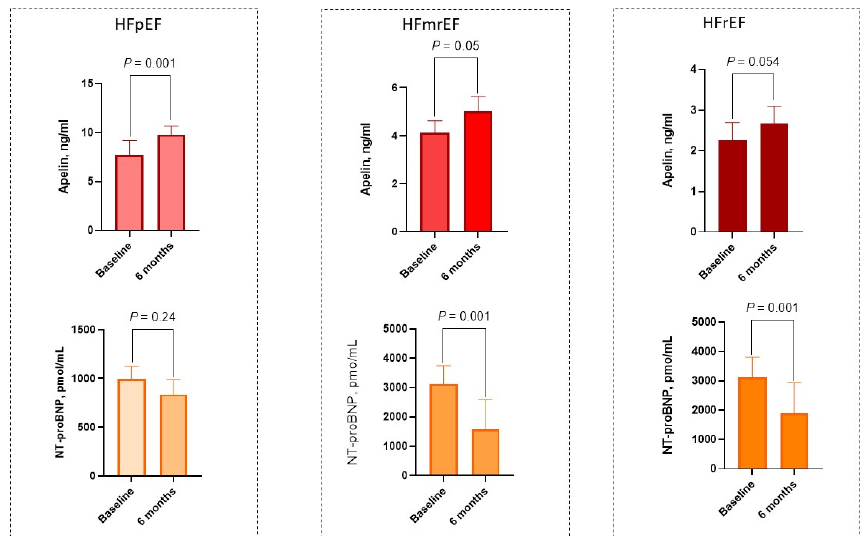
Figure 3. Bar graphs at baseline and 6 months after dapagliflozin administration, showing changes in serum levels of apelin NT-proBNP depending on the phenotypes of HF. Abbreviations: HFpEF, heart failure with preserved ejection fraction; HFmrEF, heart failure with mildly reduced ejection fraction; HFrEF, heart failure with reduced ejection fraction.